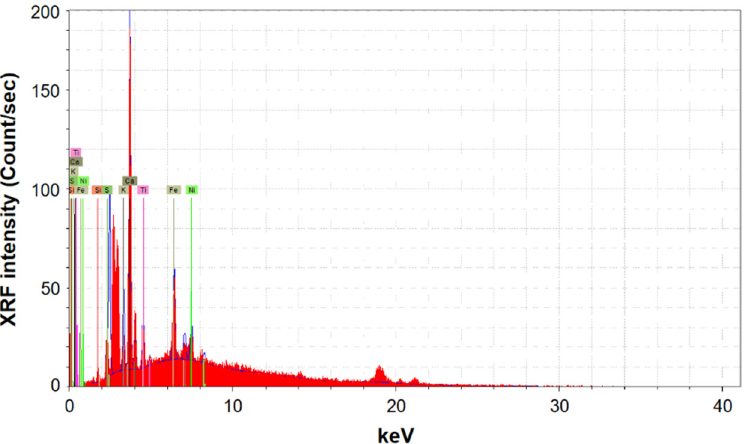
Figure 7. XRF spectra after treatment of Page 1.